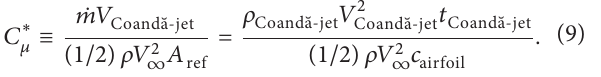
Figure 11: (a) The effect of jet thickness on the L / D and lift augmentation (Re = 1 × 10 6 , 𝑅 (c) flow separation with t =